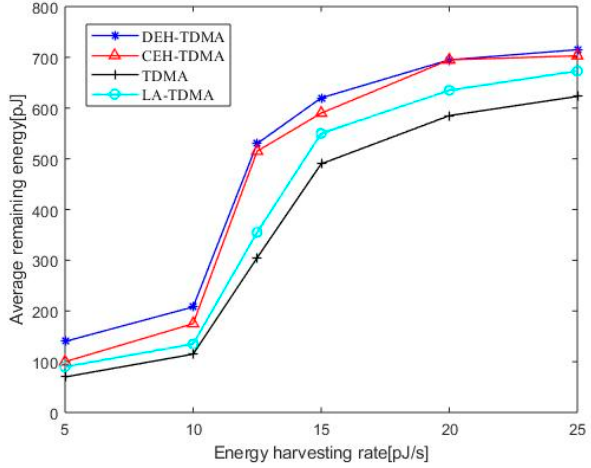
Figure 4. Average remaining energy as a function of energy harvesting rate.